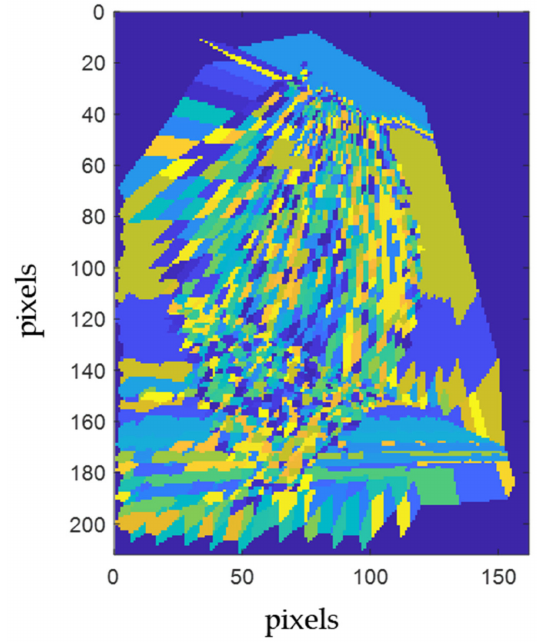
Figure 6. Result of the pairing procedure.